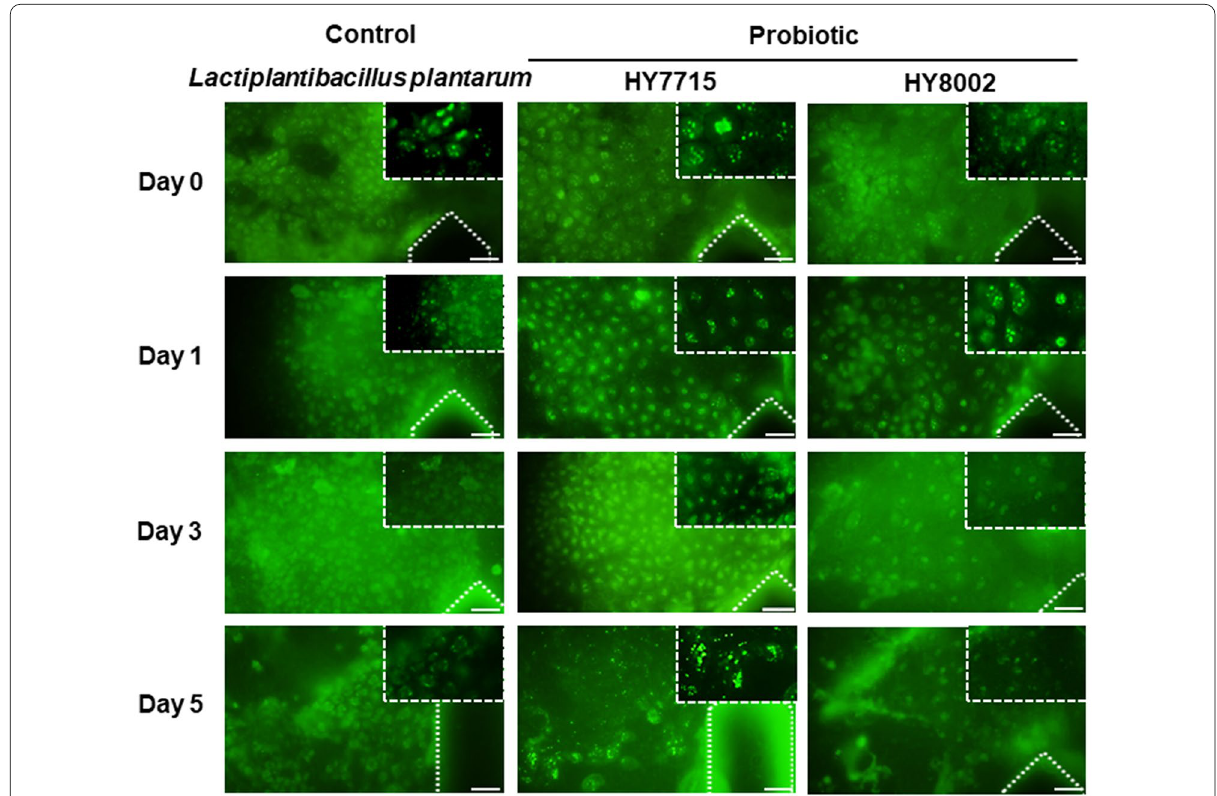
Fig. 6 Microbial co‑culture on a human intestinal epithelial monolayer in a gut‑on‑a‑chip. Bacteria were cultured on the surface of a Caco‑2 cell monolayer grown within a gut‑on‑a‑chip ( Lactiplantibacillus plantarum as a control, Lactiplantibacillus plantarum HY7715 probiotic and Bifidobacterium animalis spp. lactis HY8002 probiotic ; seeding density 1 10 8 cells/mL). Fluorescence views from above of probiotics and Caco‑2 cell × co‑cultured for 5 days and viewed at low and high (white‑dotted rectangle) magnification, which shows microcolonies of the bacteria (green spots) that remain tightly adherent to the apical surface of the Caco‑2 cell monolayer after exposure to continuous fluidic flow. Scale bars are 100